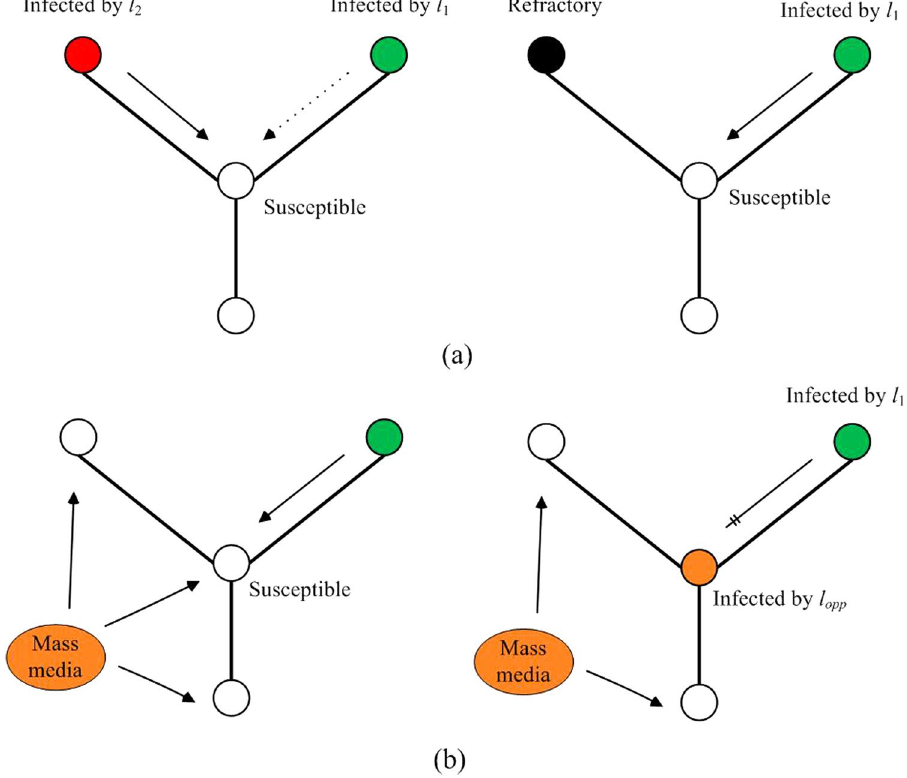
Figure 1. Graphical illustration for dynamic spread of both pieces of information in different methods. ( a ) Distract attention of nodes. When a susceptible node in the left plot receives information l 1 and l 2 at the same time, it preferentially selects information l 2 . Therefore, the transmission from infected nodes of l 1 to the susceptible node is temporarily suspended. In the right plot, when spreaders of l 2 become refractory, the transmission of l 1 is recovered. ( b ) Propagate opposite information by mass media. In the left plot, information l opp from mass media acts on all susceptible nodes. In the right plot, if a node is infected by the opposite information, the transmission from spreaders of l 1 to the node is permanently cut